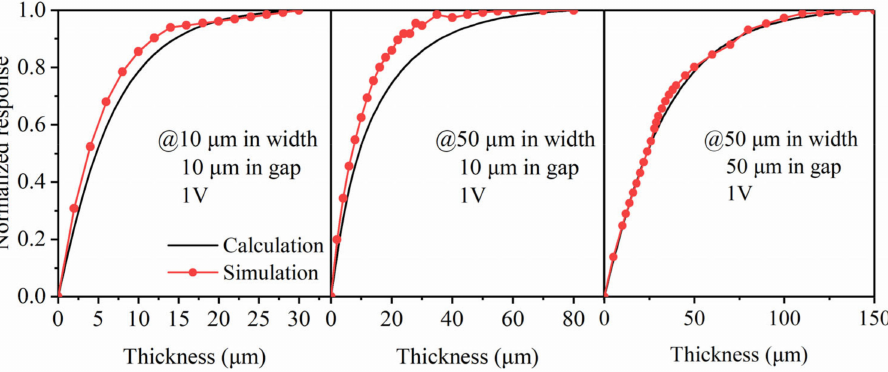
Figure 4. Calculation and simulation comparison of the relationship between the thickness and sensitivity of the sensitive layer with different IDE widths and